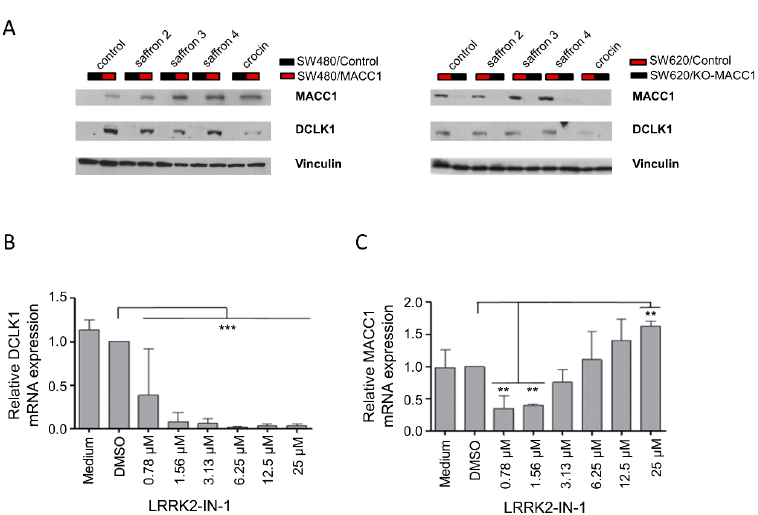
Figure 6. Saffron crudes reduced DCLK1 levels in CRC cells. Shown here are the MACC1 and DCLK1 levels in CRC cells after 48 h saffron 2–4 and crocin treatment. DCLK1 levels decreased upon 48 h saffron treatment; on the other hand, MACC1 levels increased under the same treatment ( A ). The DCLK1 inhibitor LRRK2-IN-1 led to the reduction of DCLK1 ( B ) and caused MACC1 expression change in a concentration-dependent manner ( C ). ** p < 0.01, *** p < 0.001.